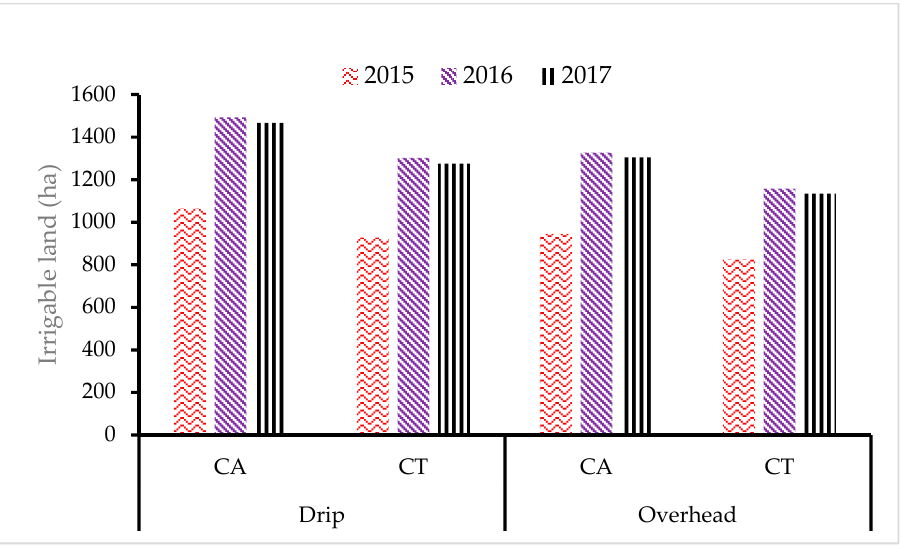
Figure 11. Potential of runoff to sustain two-season irrigation (October to June) using overhead and drip water application techniques under the conservation agriculture (CA) and conventional tillage (CT) systems for 2015, 2016, and 2017.